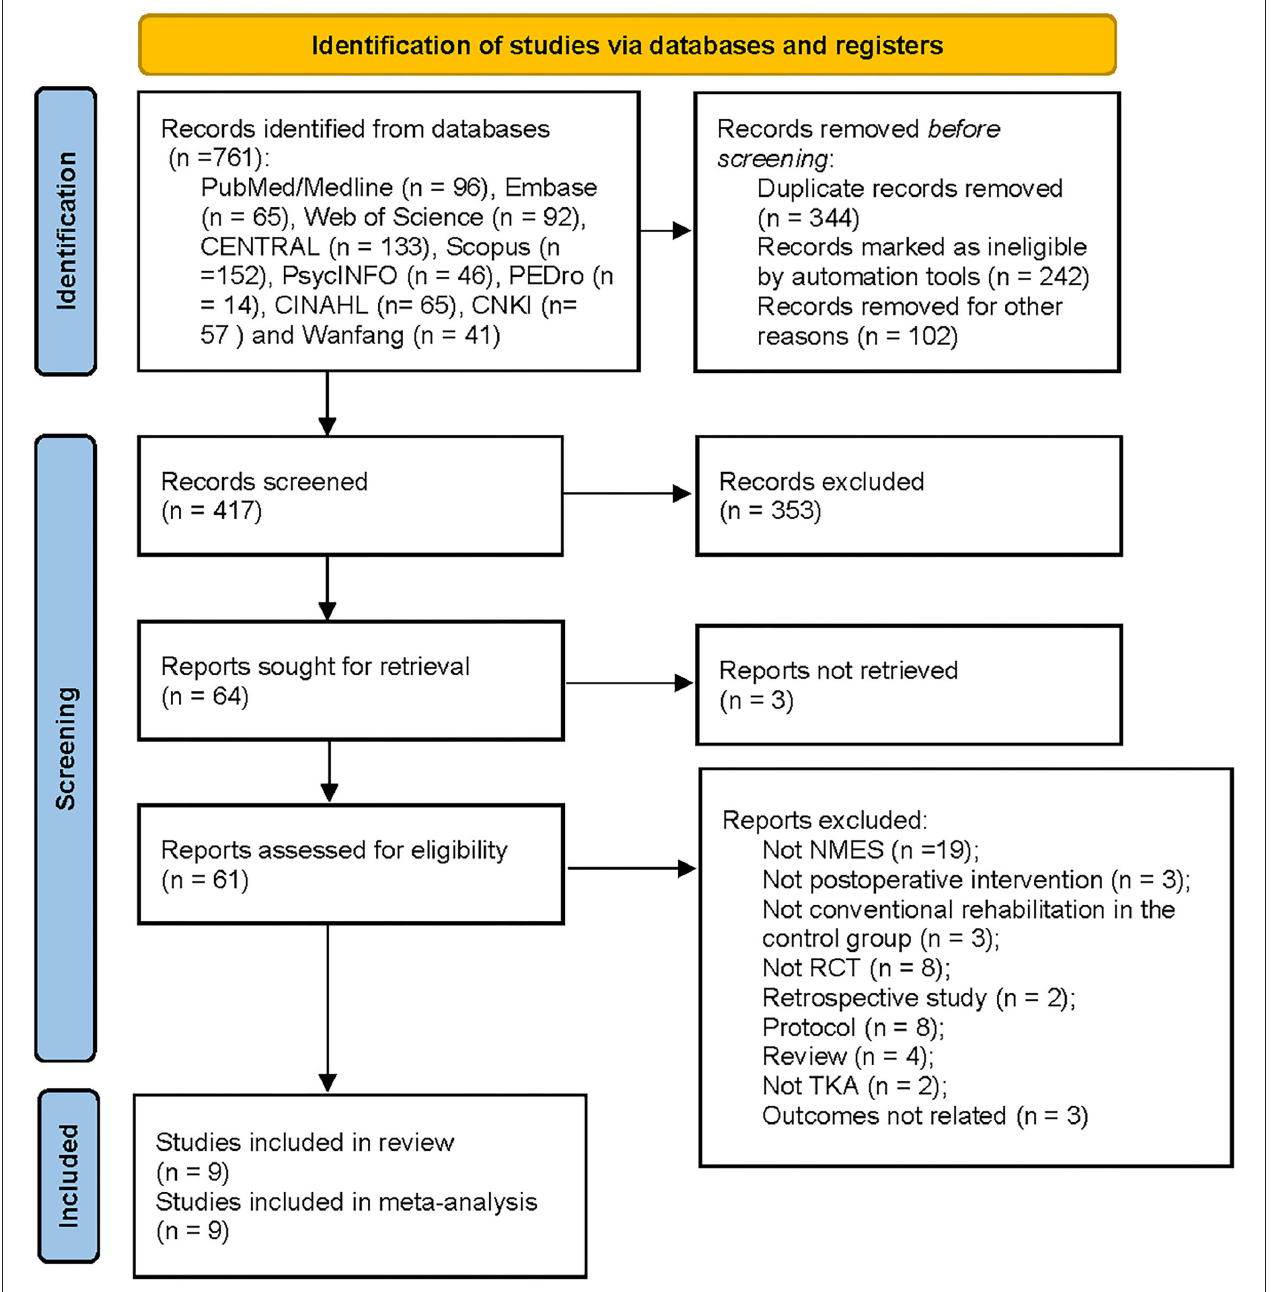
FIGURE 1 | Flow chart of studies selection according to preferred reporting items for systematic reviews and meta-analyses guidelines. EMBASE, Excerpta Medica Database; CENTRAL, Cochrane Central Register of Controlled Trials; PEDro, Physiotherapy Evidence Database; CNKI, China National Knowledge Infrastructure; TKA, Total Knee Arthroplasty; NMES, Neuromuscular electrical stimulation; RCT, Randomized Controlled Trial.